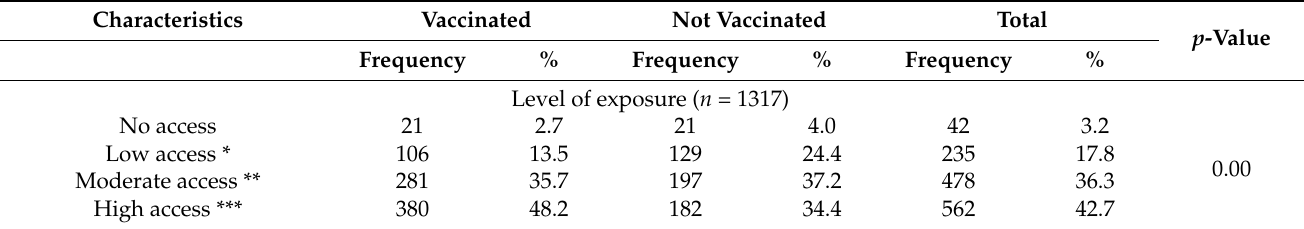
Table 2. Access to sources of